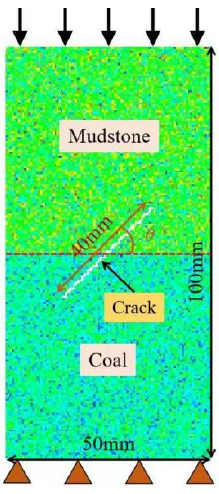
Figure 7. Numerical model. Table 2. Micro-mechanical parameters of specimen.